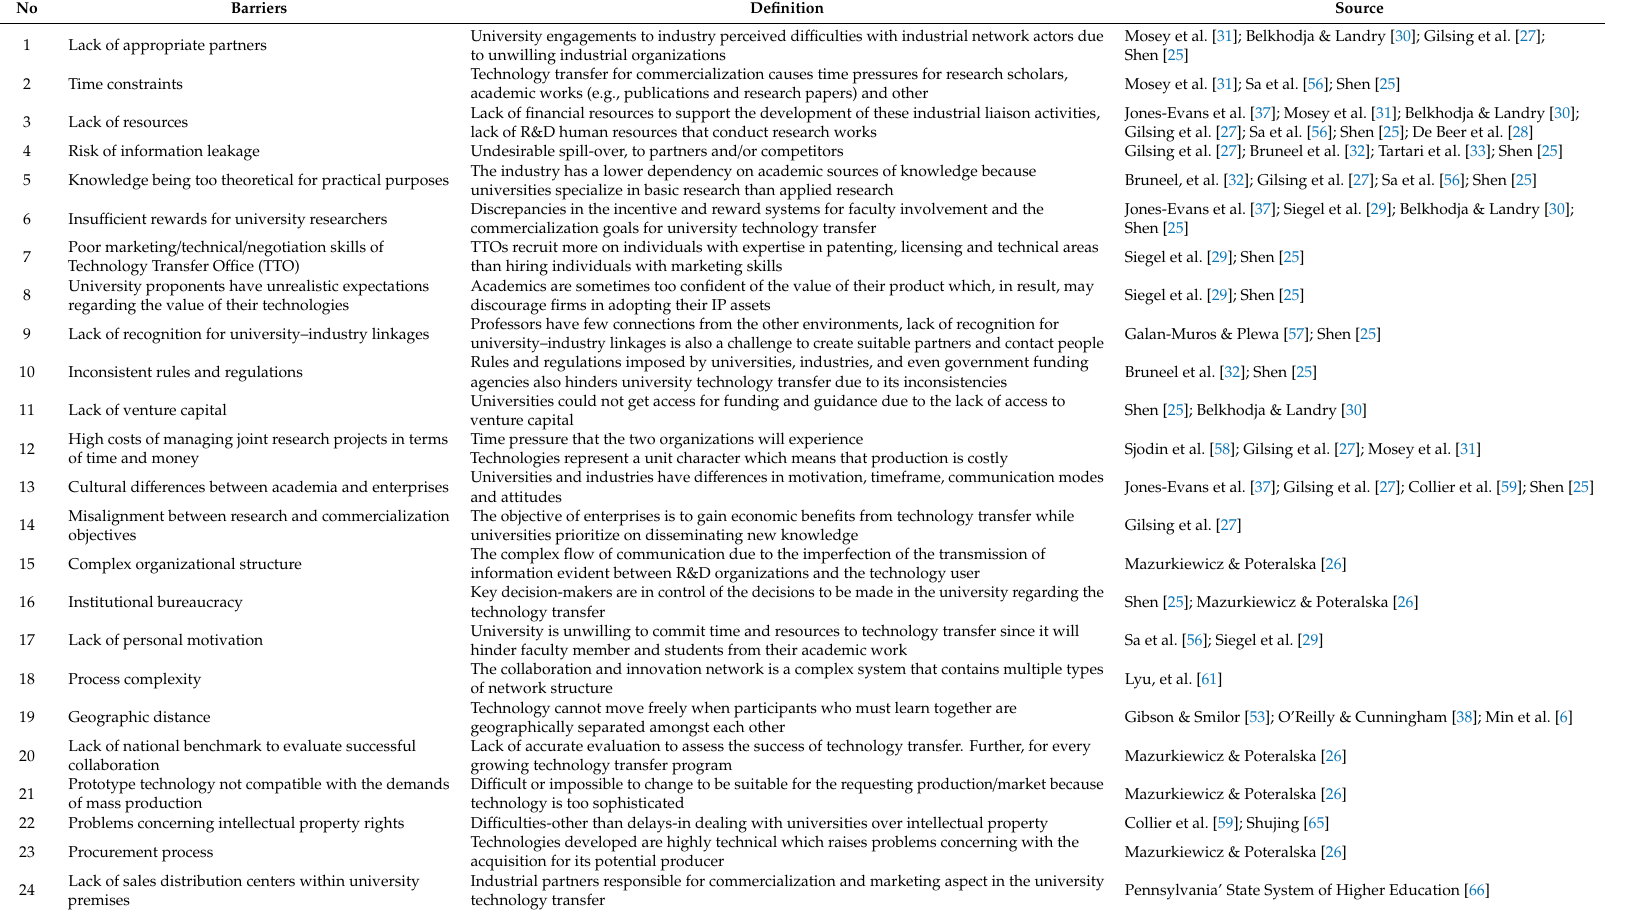
Table 4. List of barriers to university technology